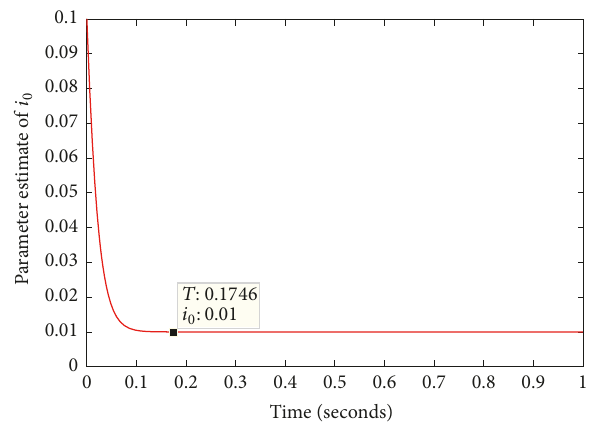
Figure 13: Time history of GAFOPID controlled parameter